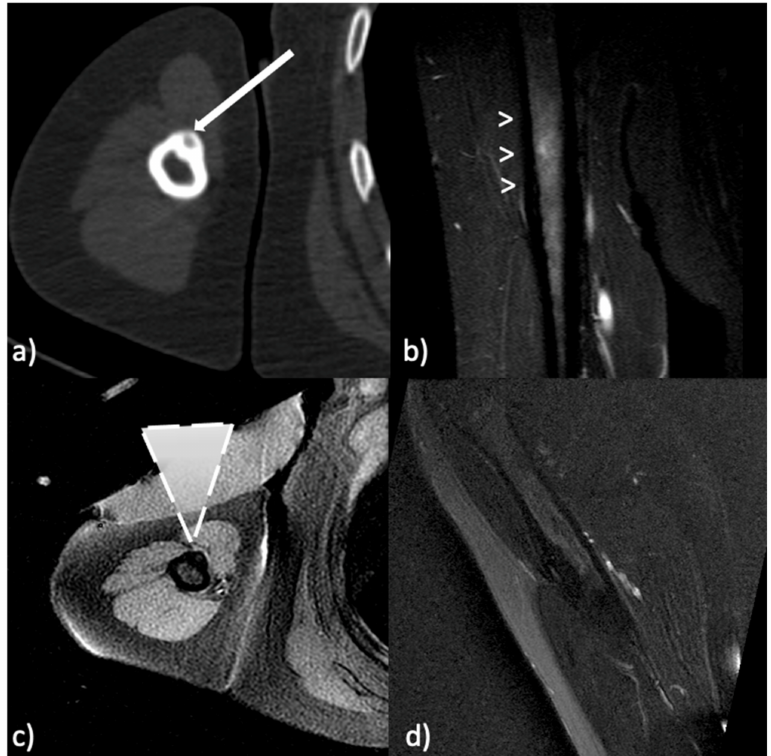
Figure 1. Osteoid osteoma of the omerus. ( a ) Pretreatment computed tomography (CT) shows the nidus (arrow) of the osteoid osteoma. ( b ) Pretreatment T2-weighted fast spin-echo magnetic resonance (MR) with fat-saturation shows bone marrow edema around the nidus (arrowheads). ( c ) MR image during treatment with the ultrasound (US) transducer in contact with the skin (dashed triangle represents the US beam focused on the target). ( d ) 1-year follow-up T2-weighted fast spin-echo MR with fat-saturation shows resolution of the bone